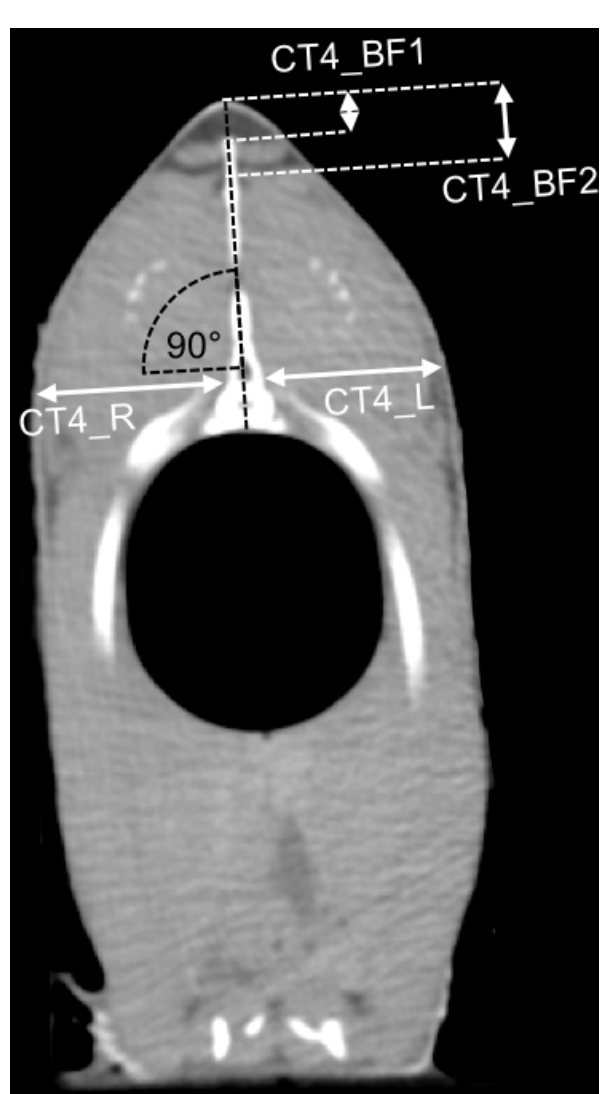
Figure 3. CT cross section 2.1cm before the first ray of the dor- sal fin. The back-fat thickness was measured in two different thick- nesses (CT4_BF1, CT4_BF2). The thickness of the fillet was mea- sured on the right and left side (CT4_R,